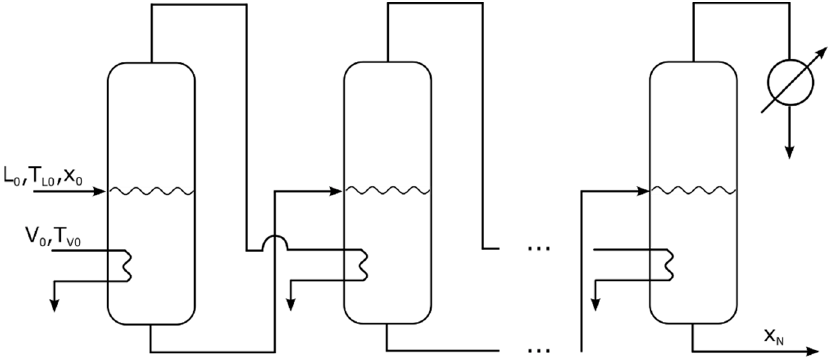
Figure 2. Concurrent multiple-effect evaporator.